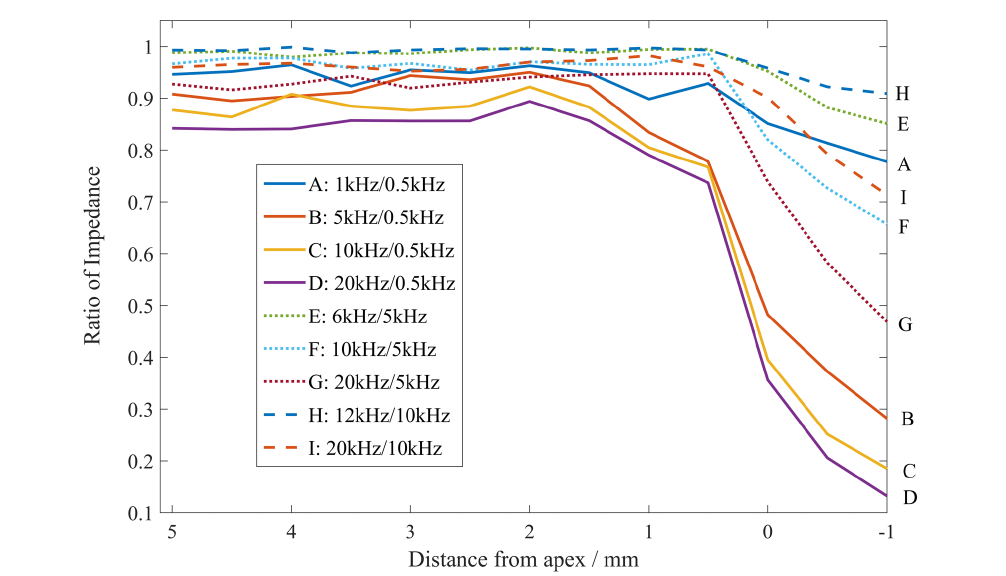
Figure 10. The impedance ratios of nine groups of frequency combinations varying with the distance between the file and the apical foramen (molar,